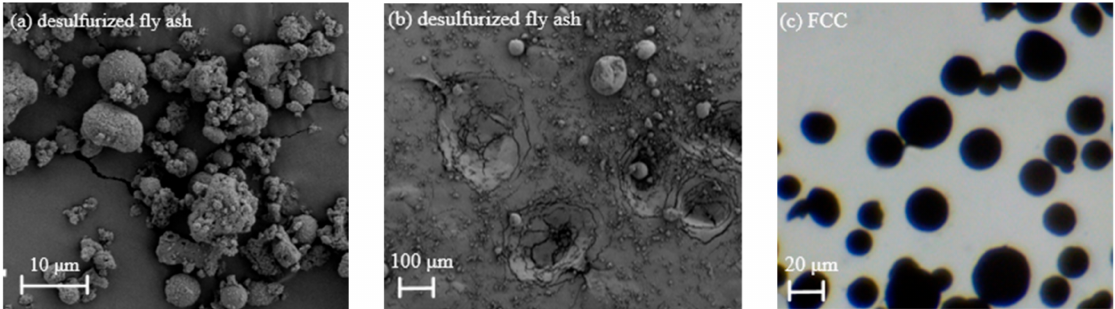
Figure 2. Morphology of desulfurization ash particles and FCC particles.